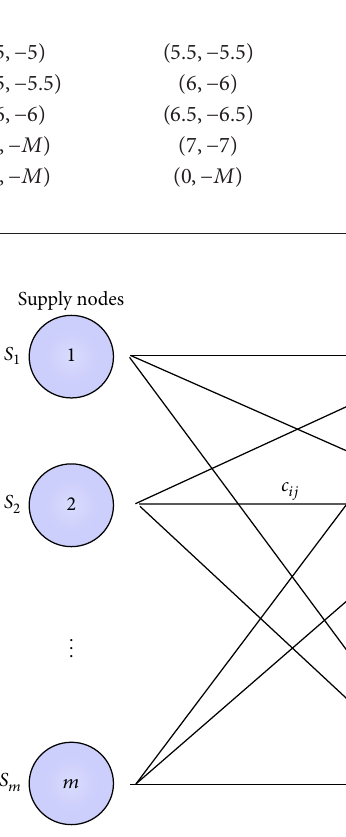
Figure 2: Architecture of traditional transportation